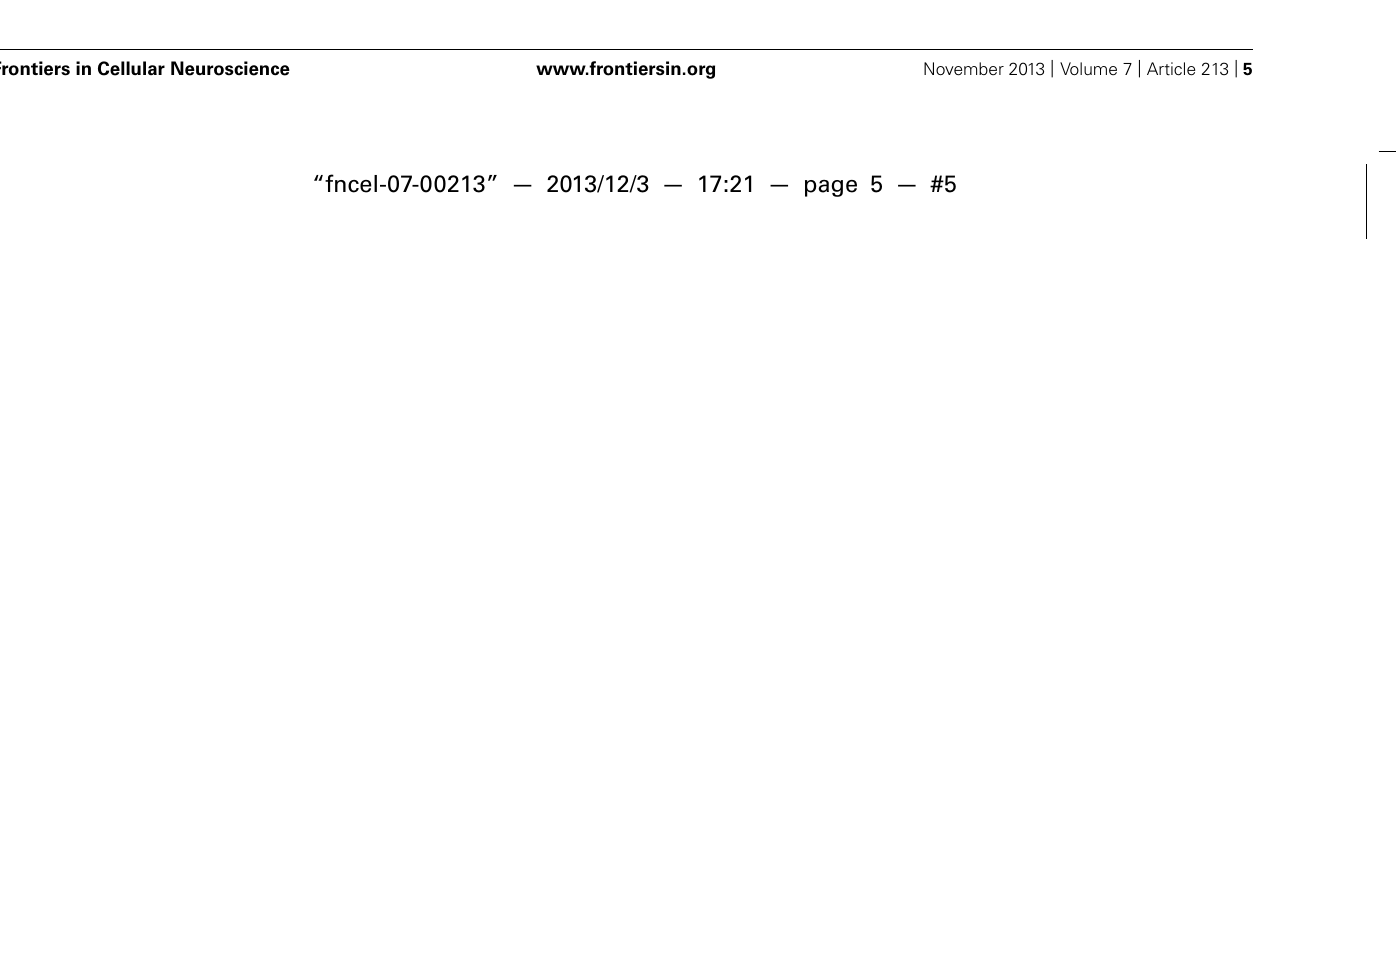
gamma range (37–43 Hz). (C , D) represent the relative power induced by laser stimulation (see Methods). (C) Optical stimulation at 8 Hz did not significantly increase oscillations. (D) In contrast, optical stimulation at 40 Hz significantly increased oscillations, demonstrating successful induction of gamma oscillations (paired, one-tailed, Student’s t -test: p < 0.05, n =